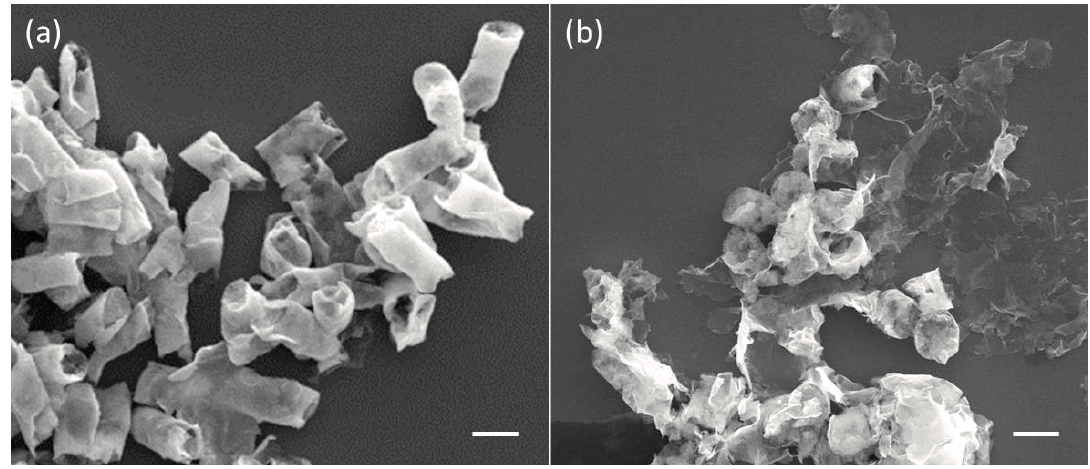
Figure 5. Biodegradable behavior of the Au NPs-(PGA/SPI) ( a ) This photograph shows the SEM images of the micro-tubes before the treatment of chymotrypsin; ( b ) This photograph shows the SEM images of the micro-tubes after the treatment of α -chymotrypsin. Scale bar = 10 μ